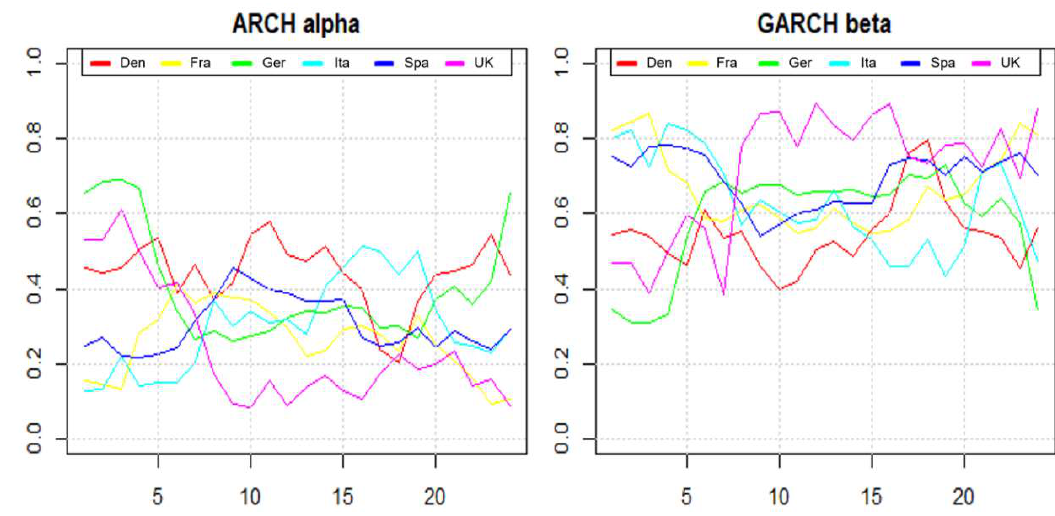
Figure 7. The values of the estimates of the two parameters of the sGARCH equation.